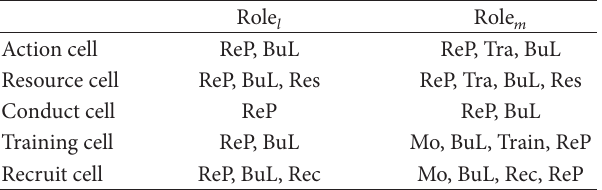
Table 2: The candidate action set of an agent in terrorist